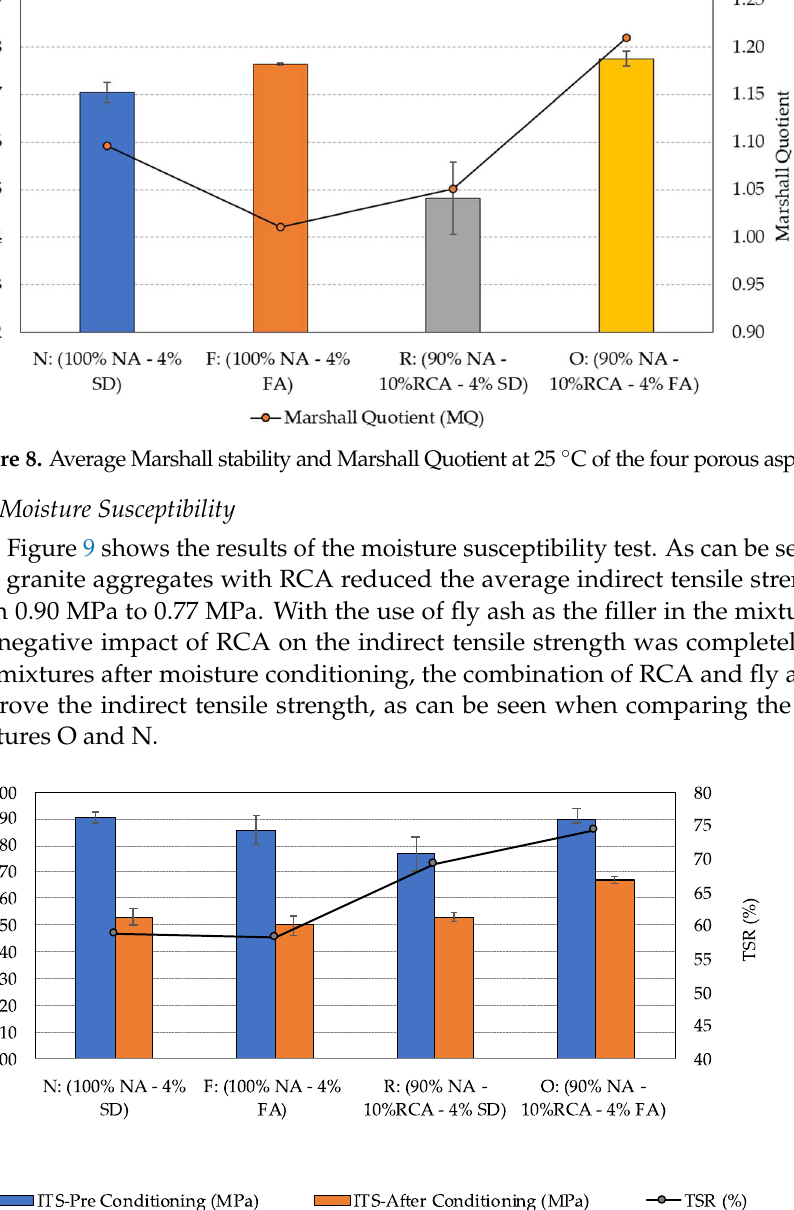
Figure 9. Average indirect tensile strength and TSR at 25 ◦ C of the four porous asphalt Figure 9 . Average indirect tensile strength and TSR at 25 °C of the four porous asphalt mixtures.